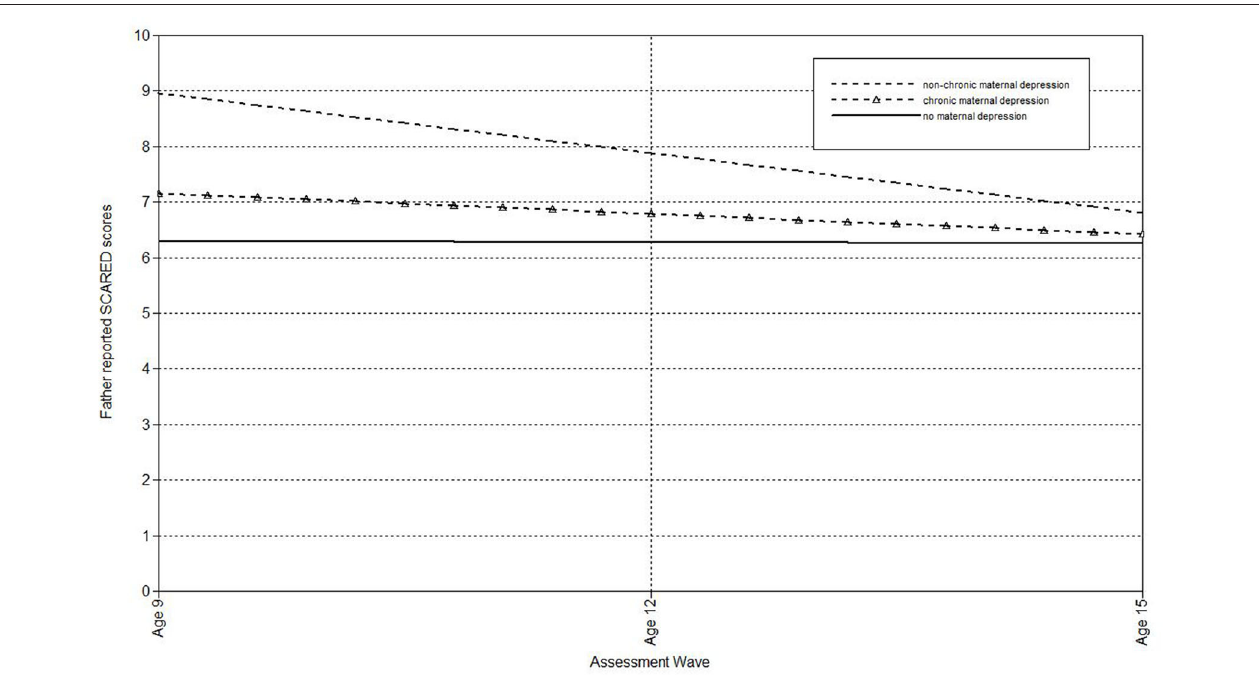
FIGURE 1 | Effect of non-chronic maternal depression (DSM approach) on the slope of father-reported SCARED scores in